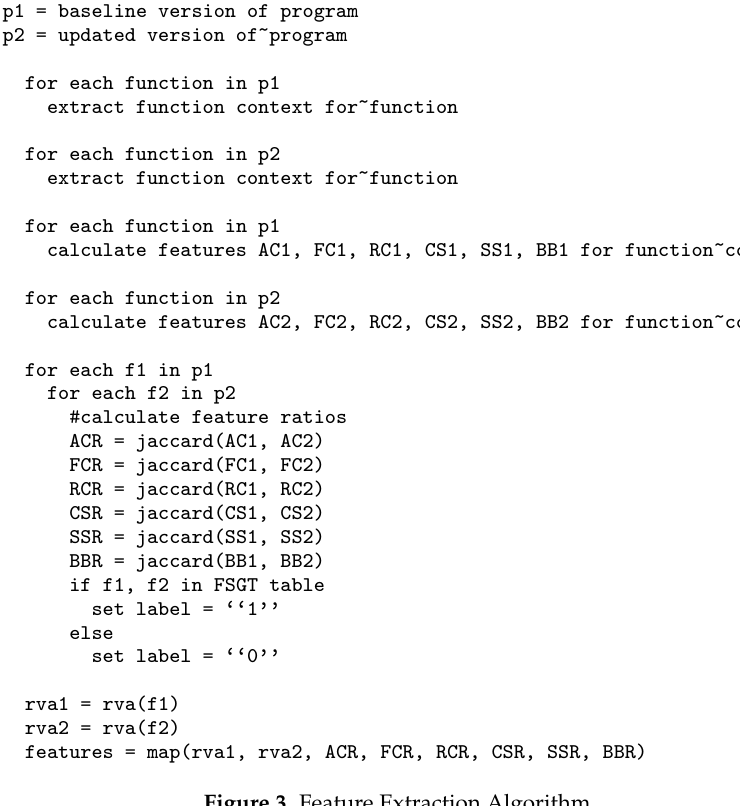
Figure 3. Feature Extraction Algorithm.